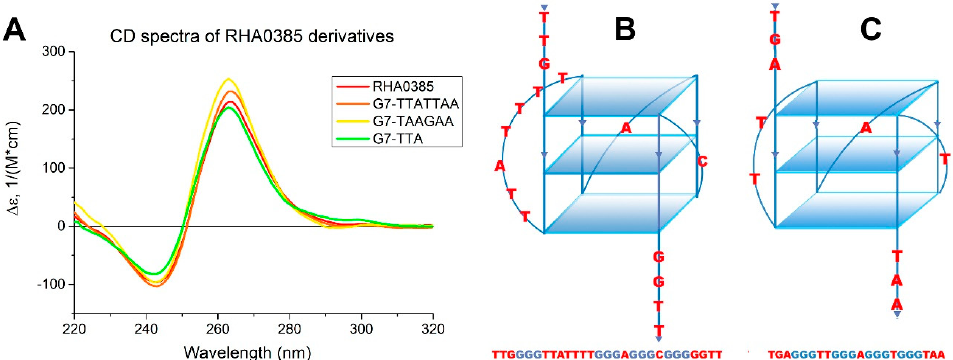
Figure 1. ( A ) The CD spectra of RHA0385 and its derivatives at 20 °C in PBSK have the positive band at 263 nm and negative band at 243 nm, which are characteristic for the parallel G-quadruplex. ( B ) Schematic drawing of putative structure of RHA0385 aptamer as a parallel G-quadruplex with three G-quartets and 7:1:1 loops. The major 7-nucleotide loop has the TTATTTT sequence. ( C ) Schematic drawing of structure of the parallel G-quadruplex 11/23 with 2:1:1 loops, described previously [33]. The loops of G-quadruplexes usually consist of non-guanine nucleotides between G-blocks that form G-tetrads [42]. Thus, the 7 nucleotides TTATTTT between the first and second G-blocks in RHA0385, as well as the single nucleotides A and C between subsequent G-blocks, are loops (Figure